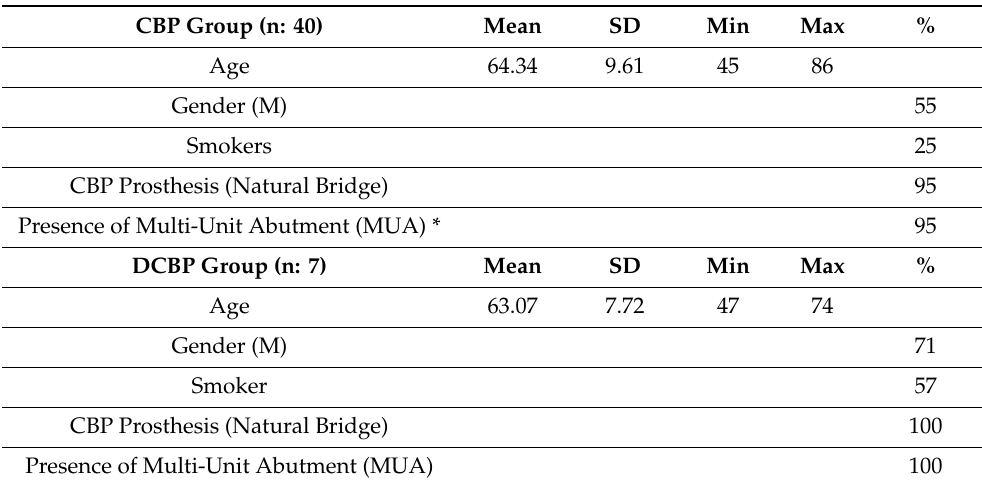
Table 1. Baseline population